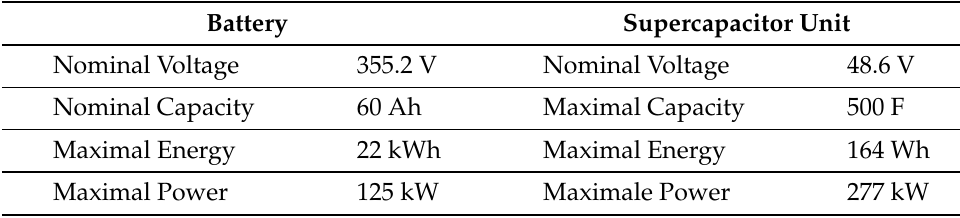
Table 2. Specifications of the HESS battery and supercapacitor